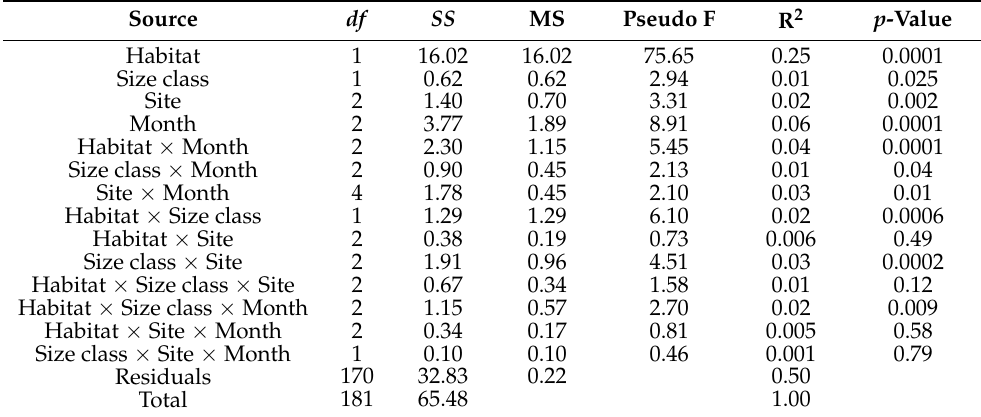
Table 4. PERMANOVA partition of the diet composition variation of the 182 analyzed catfish harvested in Lake Maggiore (12 prey species) based on arcsin square rooted numerical abundances and Bray-Curtis dissimilarities with p-value calculated after 9999 permutations.